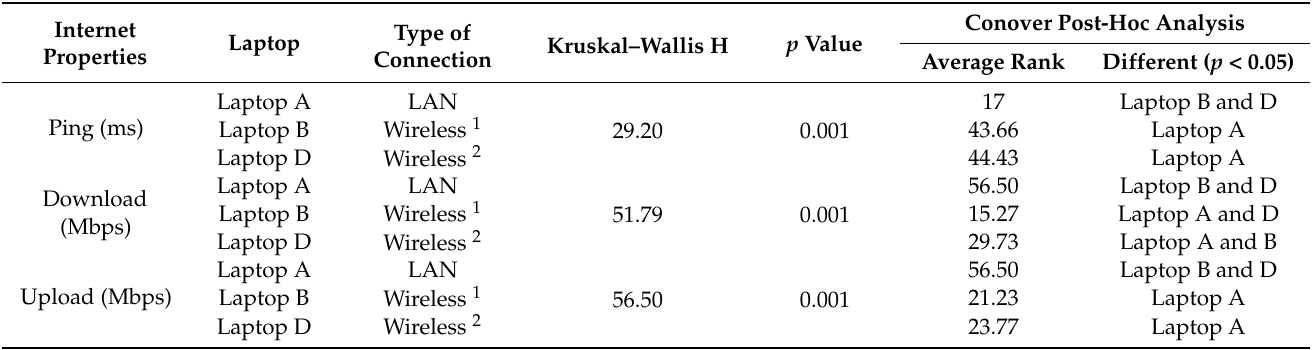
Table A1. Internet properties in the different type of connectivity in different laptops.